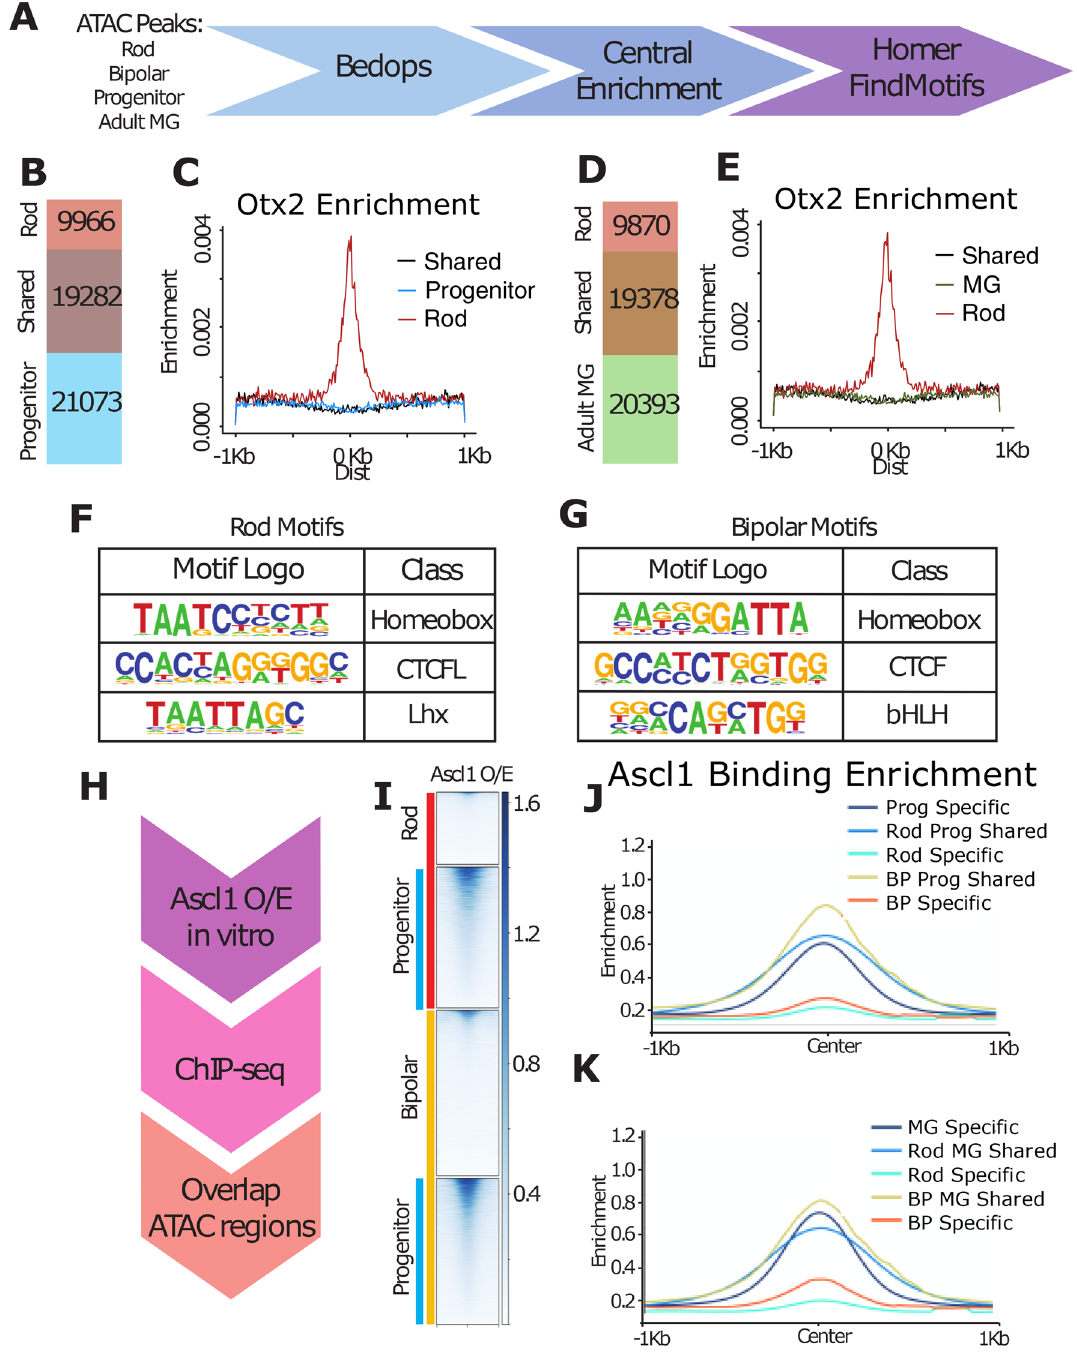
Figure 6. Ascl1 binding to accessible regions of rods and bipolar cells. ( A ) Analytical design comparing the accessible regions in neurons 9,30 (ATAC-seq from progenitors and MG). ( B , D ) Rod chromatin accessibility overlaps with both progenitor ( B ) and adult MG ( D ) accessibility by 19 k regions. ( C , E ) OTX2 predicted central enrichment is high in Rod-specific accessible regions, and low in regions shared with progenitors ( C ) and adult MG ( E ). ( F , G ) Predicted motifs for rod-specific ( F ) and Bipolar-specific ( G ) accessible regions. ( H ) Experimental design for ASCL1 ChIP-seq. ( I ) ASCL1 ChIP-seq read density (RPKM) in Rod, Bipolar, and Progenitor accessible regions. ( J , K ) Central enrichment (RPKM) for ASCL1 binding in rod, bipolar, and progenitor ( J ) or adult MG ( K ) accessible